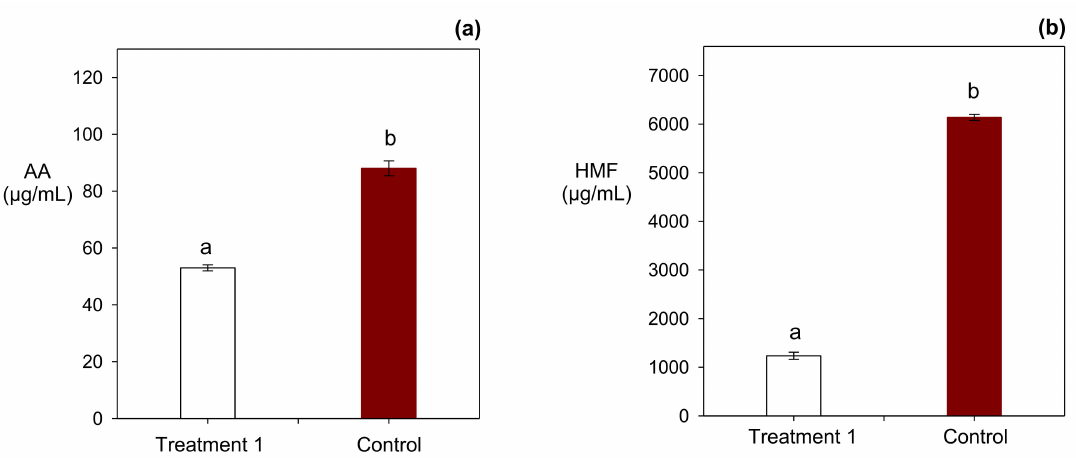
Figure 1. Effect of the red Tara pod and NaCl addition on the AA and HMF content of crackers. Different low case letters indicate statistically significant differences ( p < 0.05) between the control sample and the treatment 1 ( a ) AA content of control and treatment 1 ( b ) HMF content of control and treatment